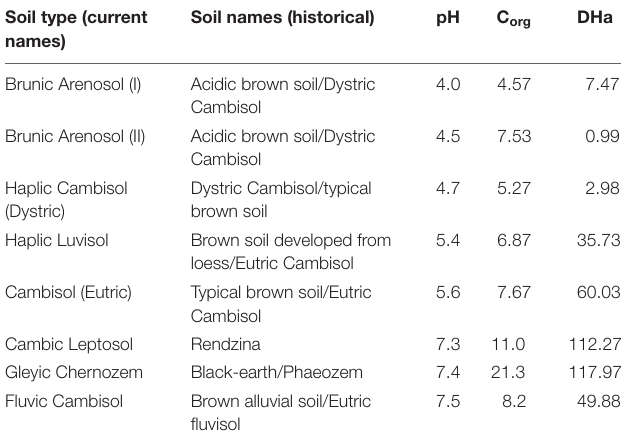
TABLE 2 | Types of soil used in the